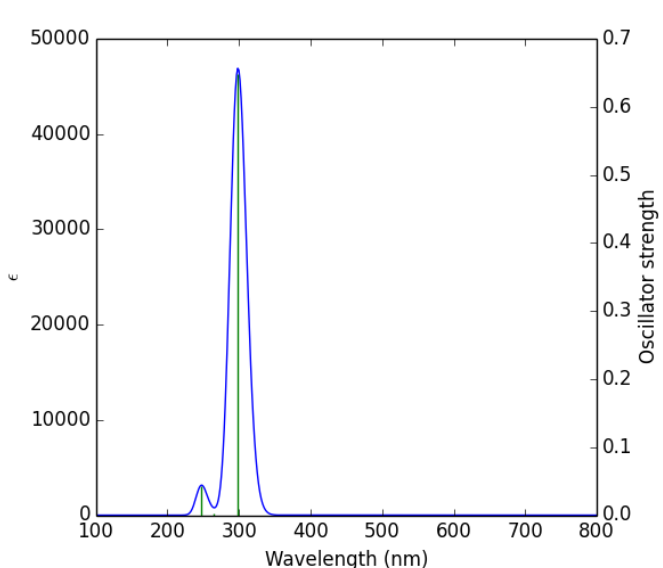
Figure 5. Theoretically calculated UV-Vis spectrum of 1 .